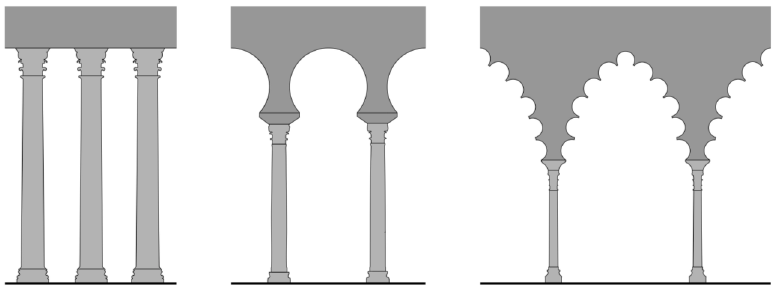
Figure 5. Schematic comparison of the design of arcades: Corinthian order of Roman architecture; arcade of horseshoe-shaped arches at Mad ī nat al-Zahr ā ʾ (mid-10th century); arcade of multi-foil, pointed arches at the Aljafería (11th century). Drawing by Felix Arnold.